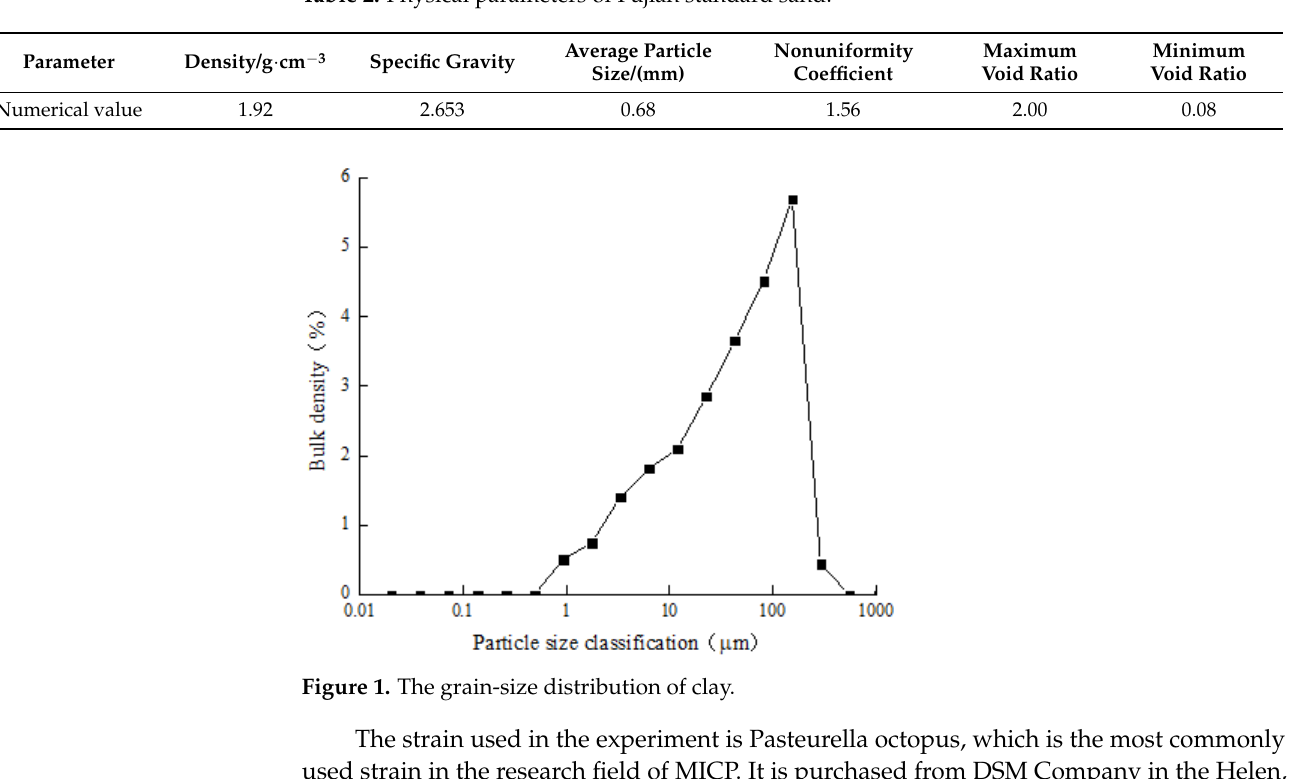
1 Figure 2. X-ray diffraction pattern of clay. Figure 3. Gradation curve of Fujian standard sand.